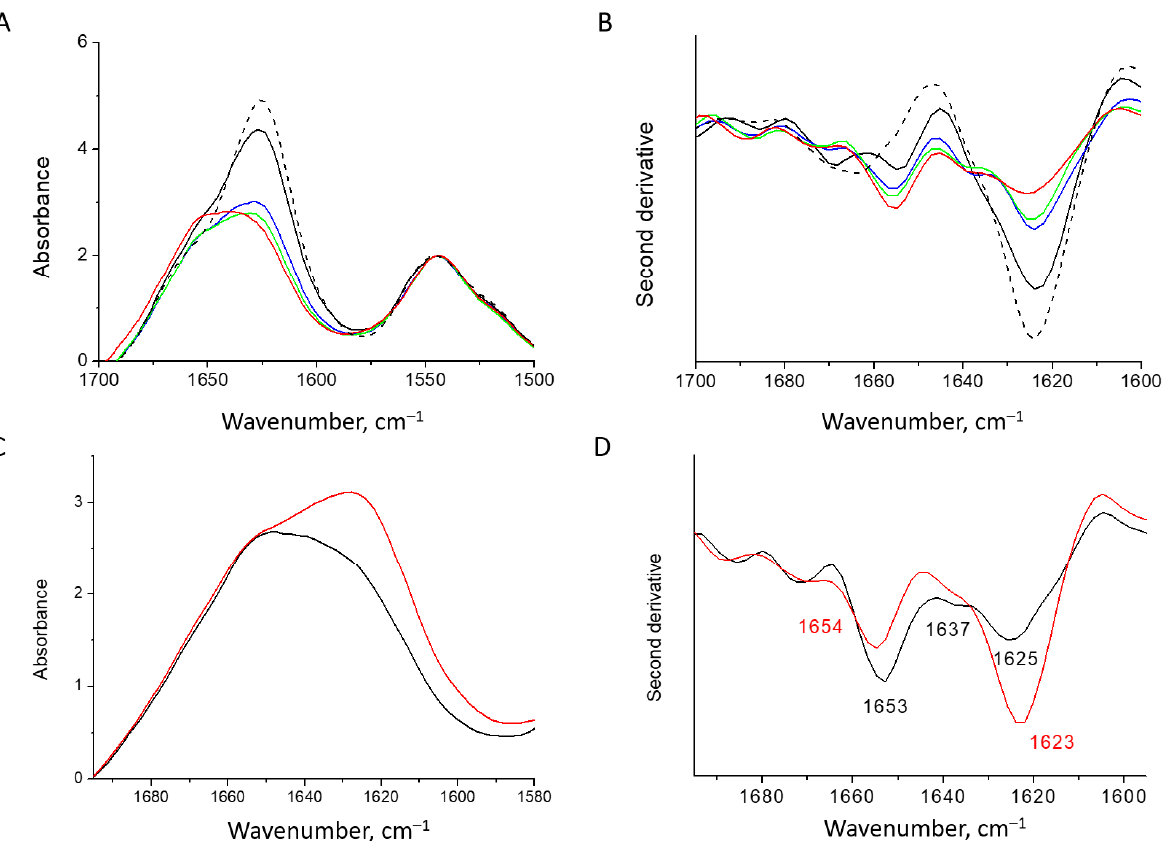
Figure 3. Absorbance spectra ( A ) and second derivative spectra ( B ) of the HEWL fibrils at 25 °C: dashed line—initial mature fibrils; black, blue, green and red—fibrils dialyzed against water for 2, 4, 6 and 24 h, respectively. Absorbance spectra ( C ) and second derivative spectra ( D ) of two fractions of the HEWL fibrils separated by centrifugation: sediment—red and